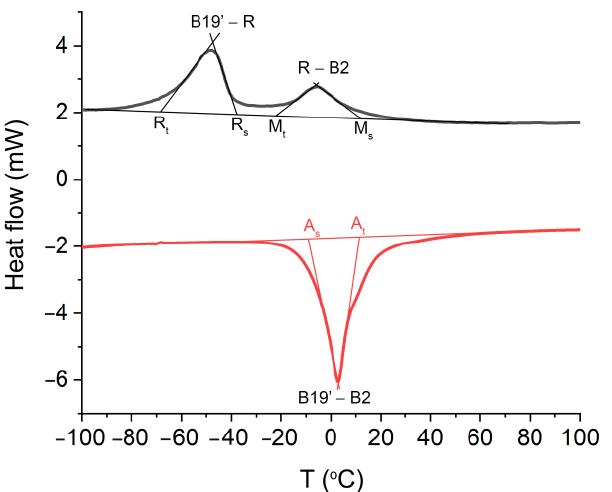
Figure 5. Cooling (black)/heating (red) curves measured for the NiTi alloy that was sintered at 700 °C per 2 h. A s —start temperature of the reverse martensitic transformation, A f —finish temperature of the reverse martensitic transformation, M s -start temperature of the forward martensitic transformation, M f —finish temperature of the forward martensitic transformation, R s —start temperature of the B2 → R transition, R f —finish temperature of the B2 → R transition, B2 → R → B19′—martensitic transformation, B19′ → B2—reverse martensitic transformation.